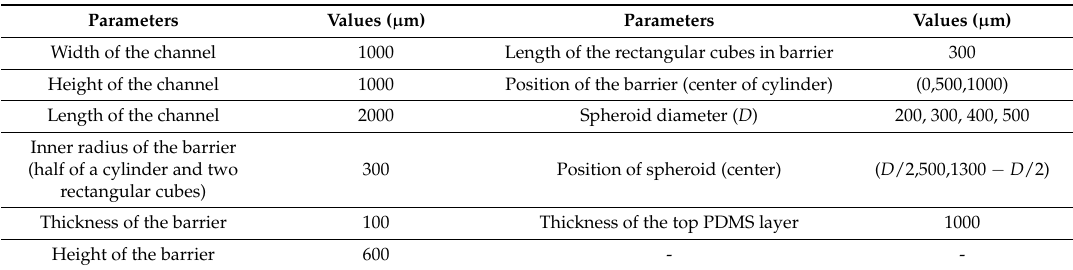
Table 1. Geometric